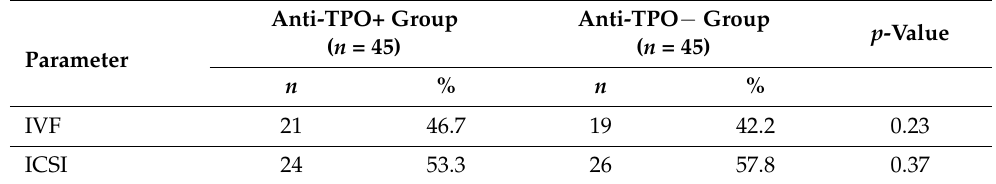
Table 4. Comparative analysis of fertilization techniques used.